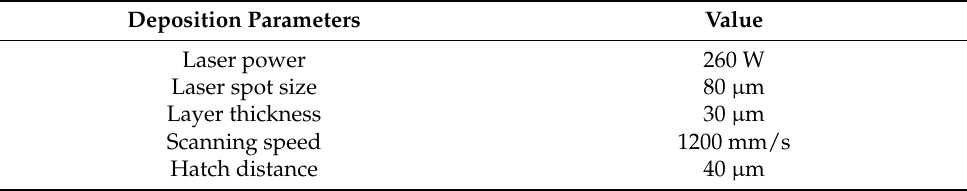
Table 2. Processing parameters for the SLM-fabricated